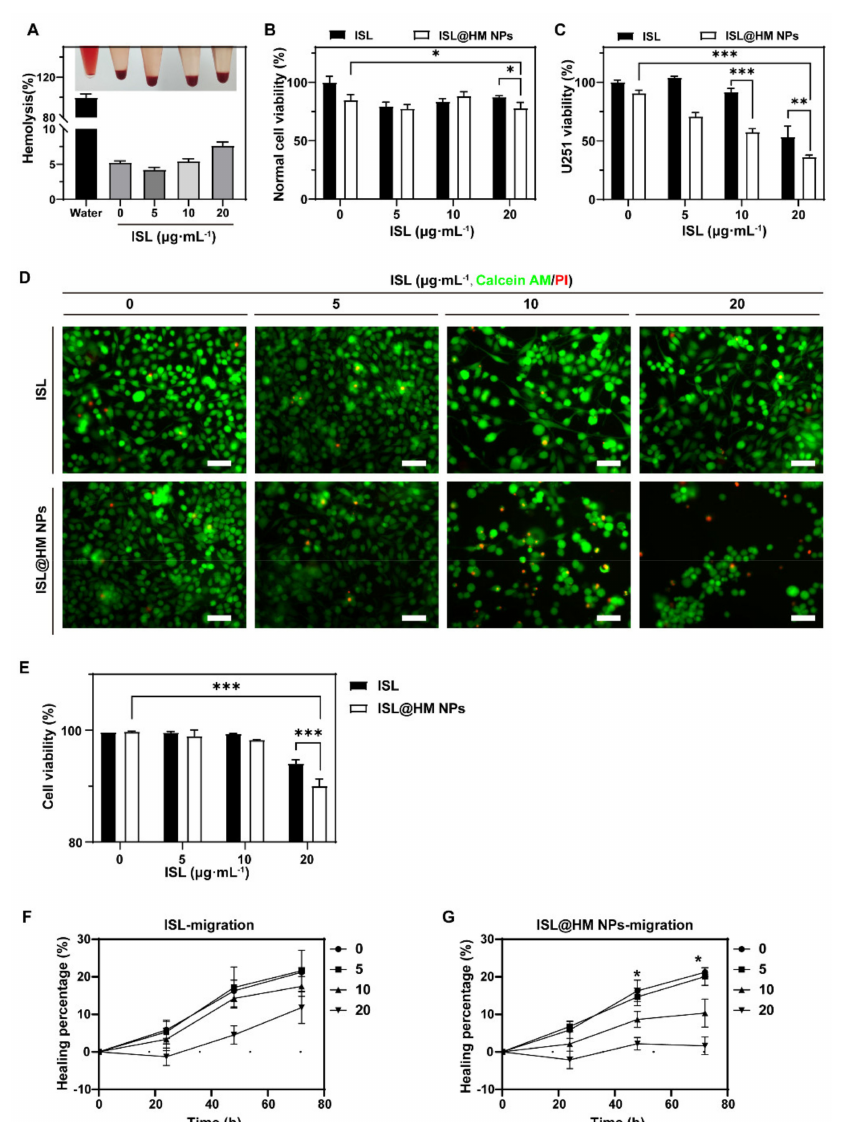
Figure 3. ( A ) Hemolysis quantification of HM at various concentrations of ISL@HM NPs. Cytotoxicity of ISL@HM NPs to HFF cells ( B ) and U251 cells ( C , D ) Live/dead staining and ( E ) the cell livability of U251 cells after different treatments (scale bar = 50 µ m). The cell migration rate of U251 cells after different concentrations of ISL ( F ) and ISL@HM NPs ( G ) treatments. ( n = 3; mean ± s.d. *** p < 0.001, ** p < 0.01 and * p < 0.05, as determined by unpaired, two − tailed Student’s t -tests. n refers to biological